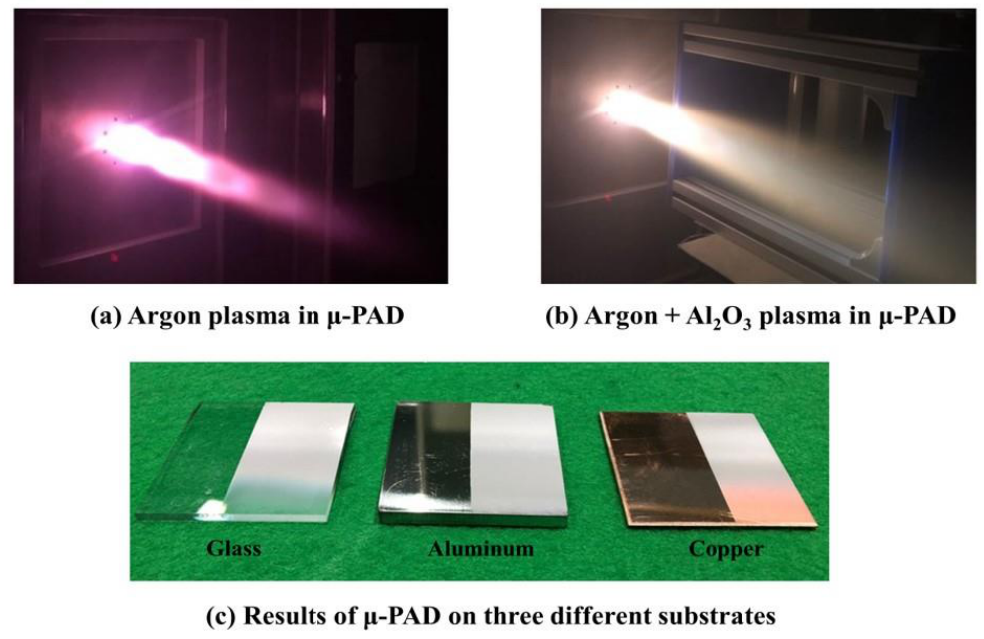
Figure 4. Argon plasma and the Al 2 O 3 powder of the µ -PAD source operate at 0.33 Torr with a microwave power of 1.5 kW. Images of ( a ) Argon plasma only, ( b ) Argon with the Al 2 O 3 powder applied, and ( c ) μ -PAD coating on various substrates (Glass, Aluminum, and Copper). Characteristics of the coated ceramic film are compared in Table 2. The total thickness Table 2. Comparing characteristics of AD and µ -PAD coating of AD is 11 μm/11 times coatings, while the thickness of μ - PAD is 96 μm/8 times coatings of the Al 2 O 3 film. It is shown that the AD method has a limit on forming thick films of 30 μm or more. On the other hand, it is possible to obtain a 96 μm thick ceramic film with μ -